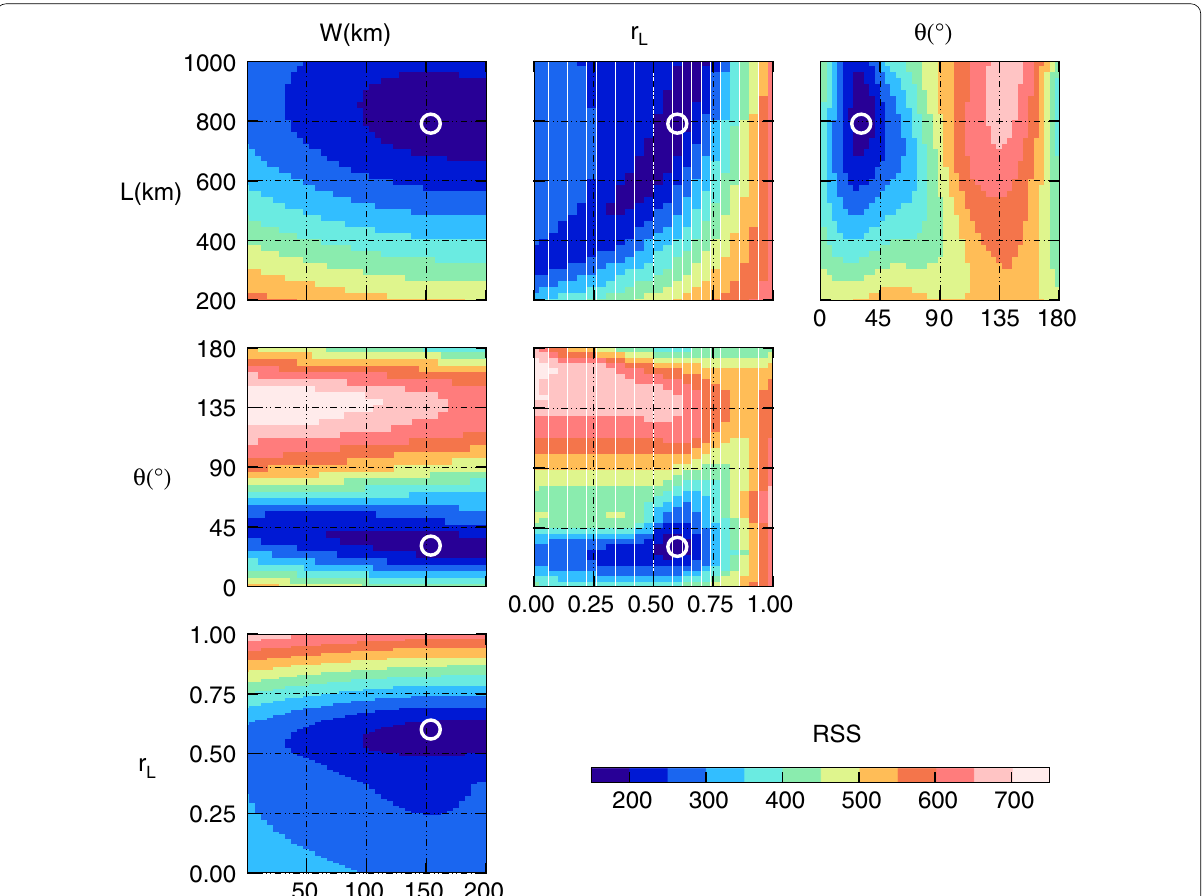
Fig. 8 Residual surface of the 4 model parameters ( L , W , θ , and r L ) at 180 s after the origin time for the 2011 Tohoku earthquake. The color bar shows the values of RSS. White circles show the minimum RSS in each